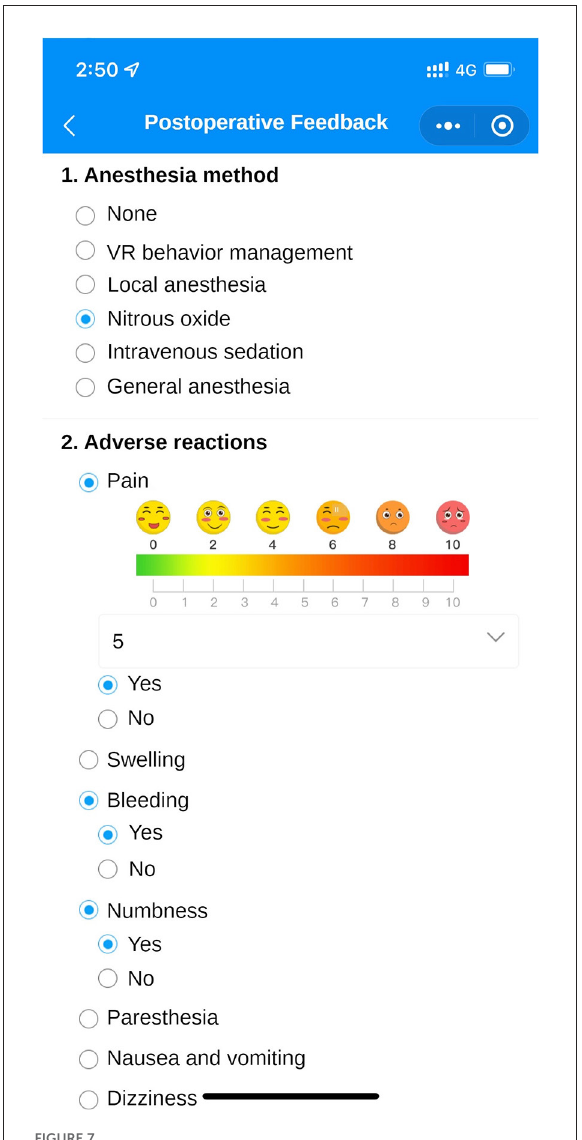
FIGURE7 Post-treatment feedback interface. After the treatment, patients can fill in the feedback of this visit in the visit record, including the anesthesia method, whether there are any adverse reactions, etc. The same can be viewed by the doctor on the doctor’s